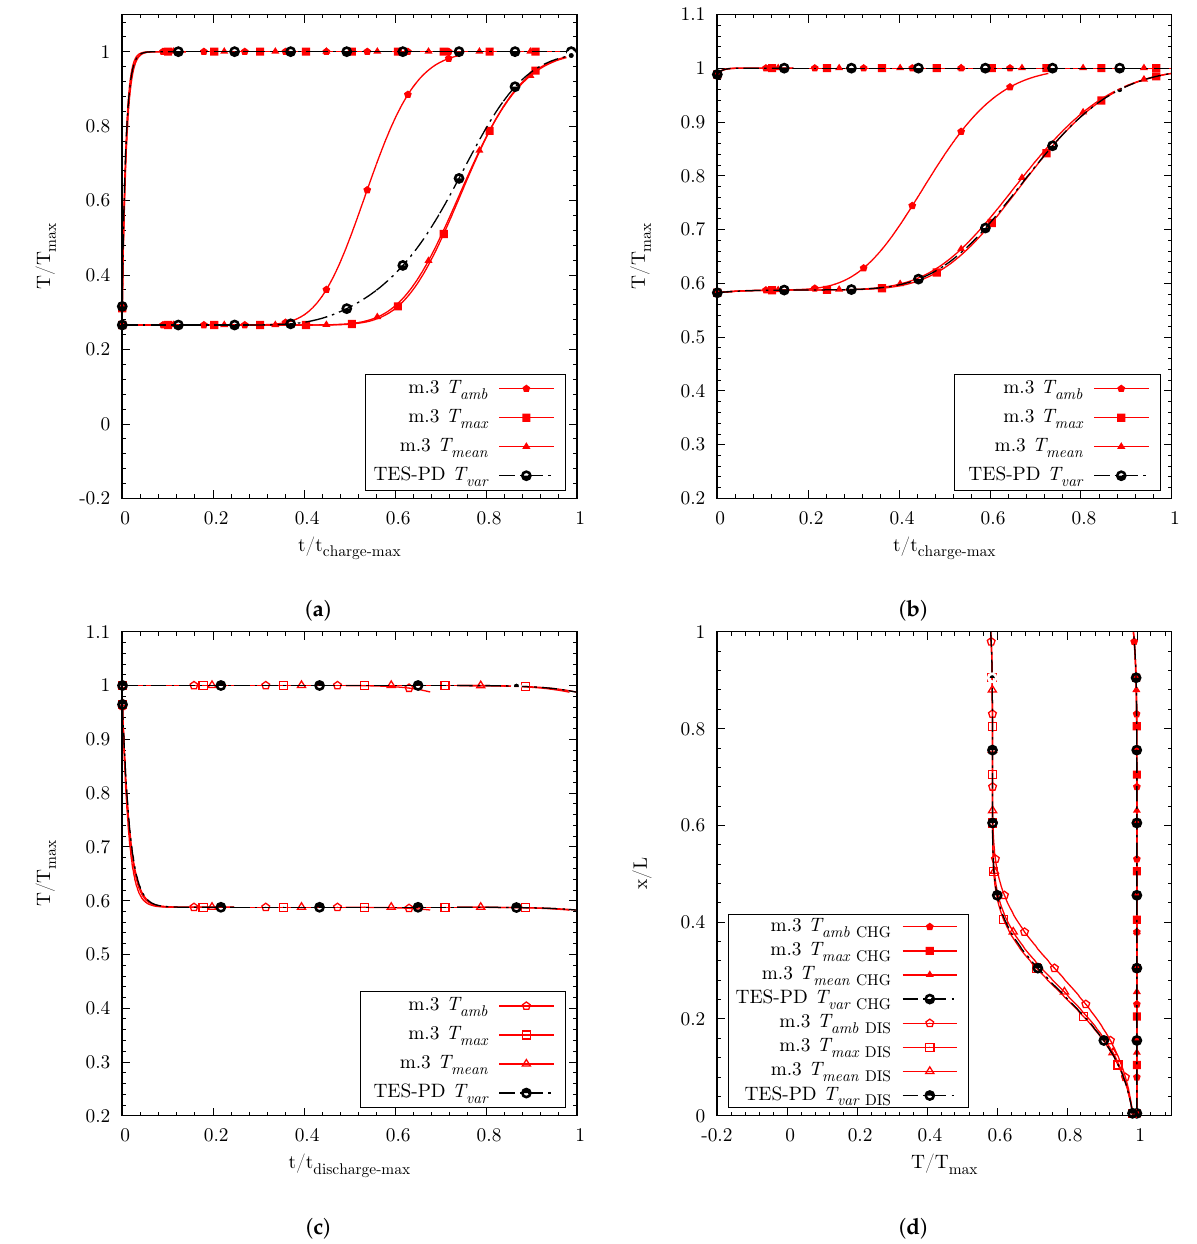
Figure 6. Comparisons of the non-dimensional curves of temperature over time. Model m.3 assumes properties ( c ps , c pf , k f and µ f ) at different reference temperatures, while model TES-PD adopts properties computed at each layer with its temperature. The reference temperatures are marked with T amb , T max , T mean and T var . ( a ) First charge temperature trends over time, ( b ) first stable cycle charge temperature trends, ( c ) first stable cycle discharge temperature trends and ( d ) temperature distributions inside the tank at the end of the first stable cycle cycle’s charge (CHG) and discharge